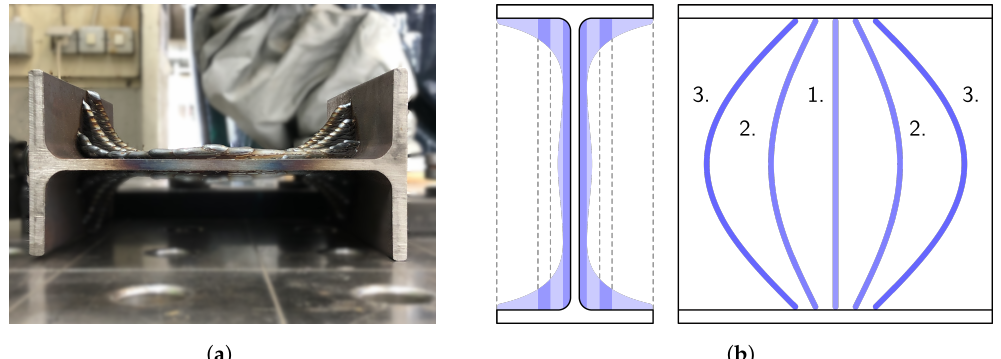
Figure 23. ( a ) Asymmetrical result due to too large deformations; ( b ) Adjusted sequence of manufac- turing stages for IIIb.